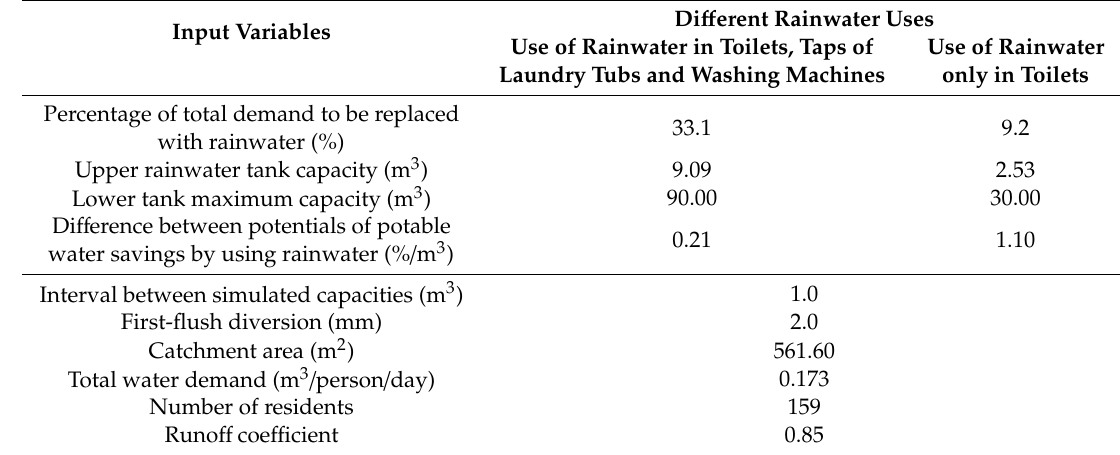
Table 6. Data used in the “Netuno” programme for sizing the lower rainwater tank under two conditions of demand.